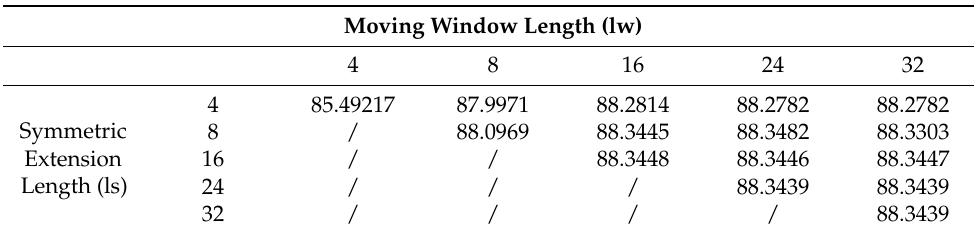
Table 10. AR results for different lw and ls combinations. AR is calculated on entire dataset used throughout Section